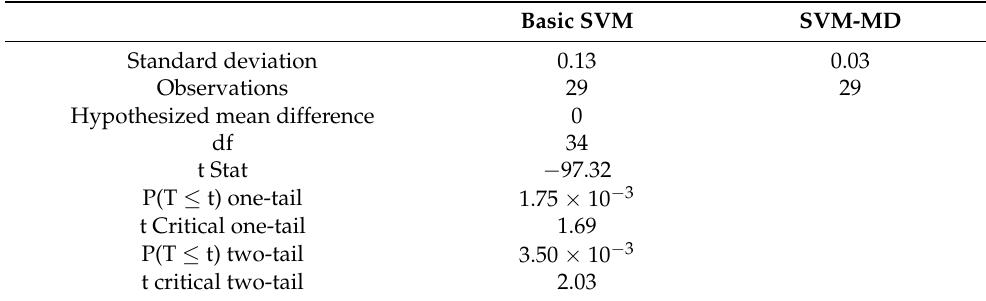
Table A1. t -test: two-sample assuming unequal variances between basic SVM and SVM-MD, simple beam.